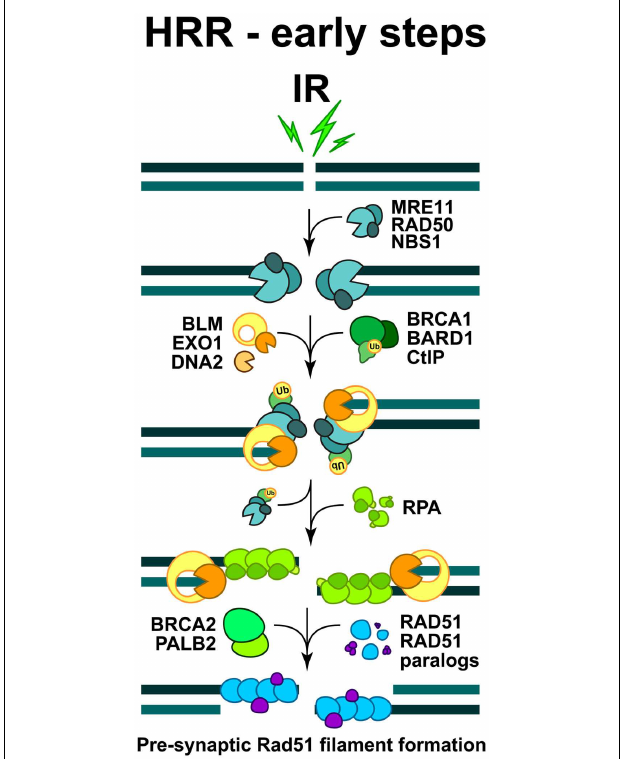
FIGURE 3 | Schematic overview of the early steps of HRR .The formation of pre-synaptic Rad51 nucleoprotein filament.The initiation steps and the full sequence of events contributing to the faithful restoration of DNA sequence at the DSB are explained in the text.